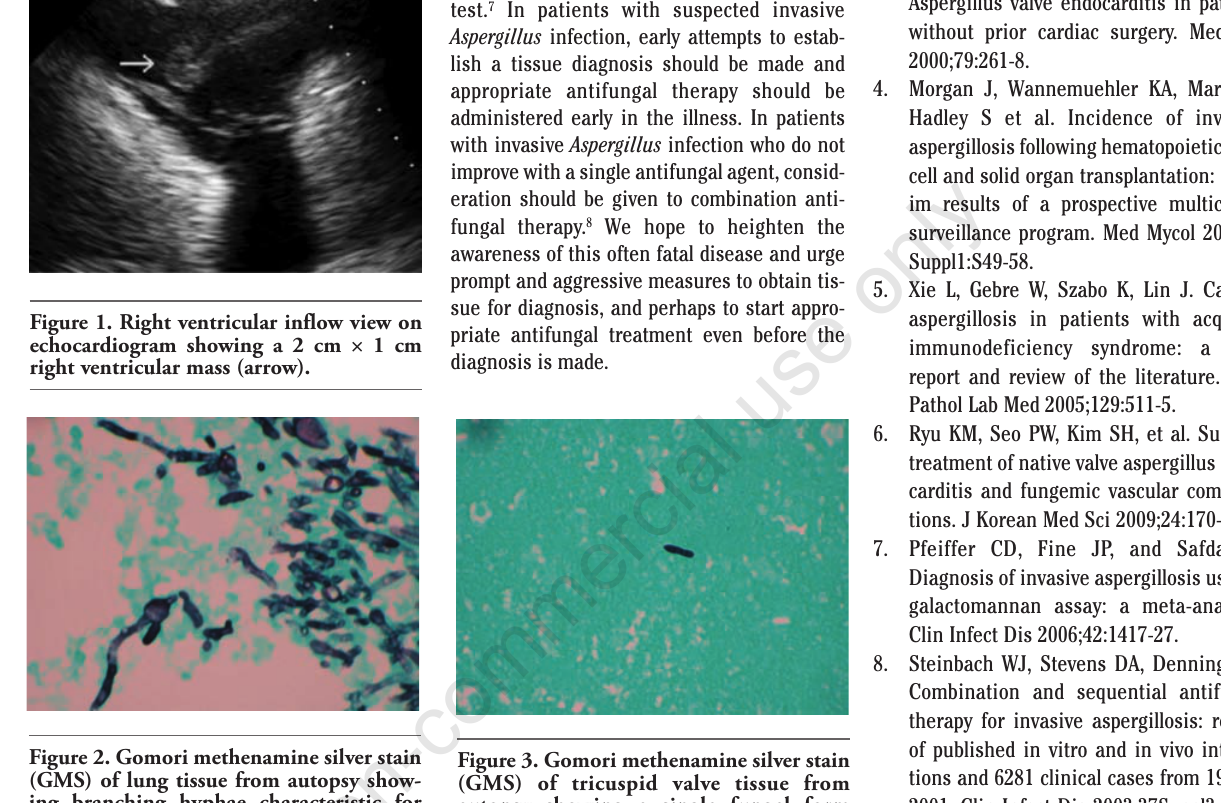
Figure 3. Gomori methenamine silver stain (GMS) of tricuspid valve tissue from autopsy showing a single fungal form